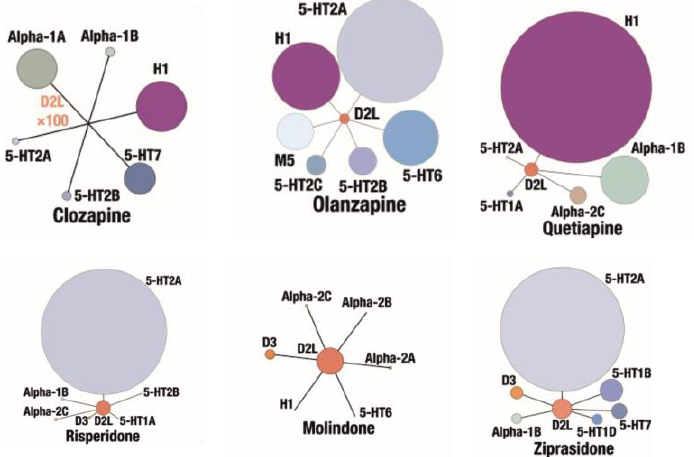
Figure 2. Examples of marketed multi-target second generation antipsychotics [1].